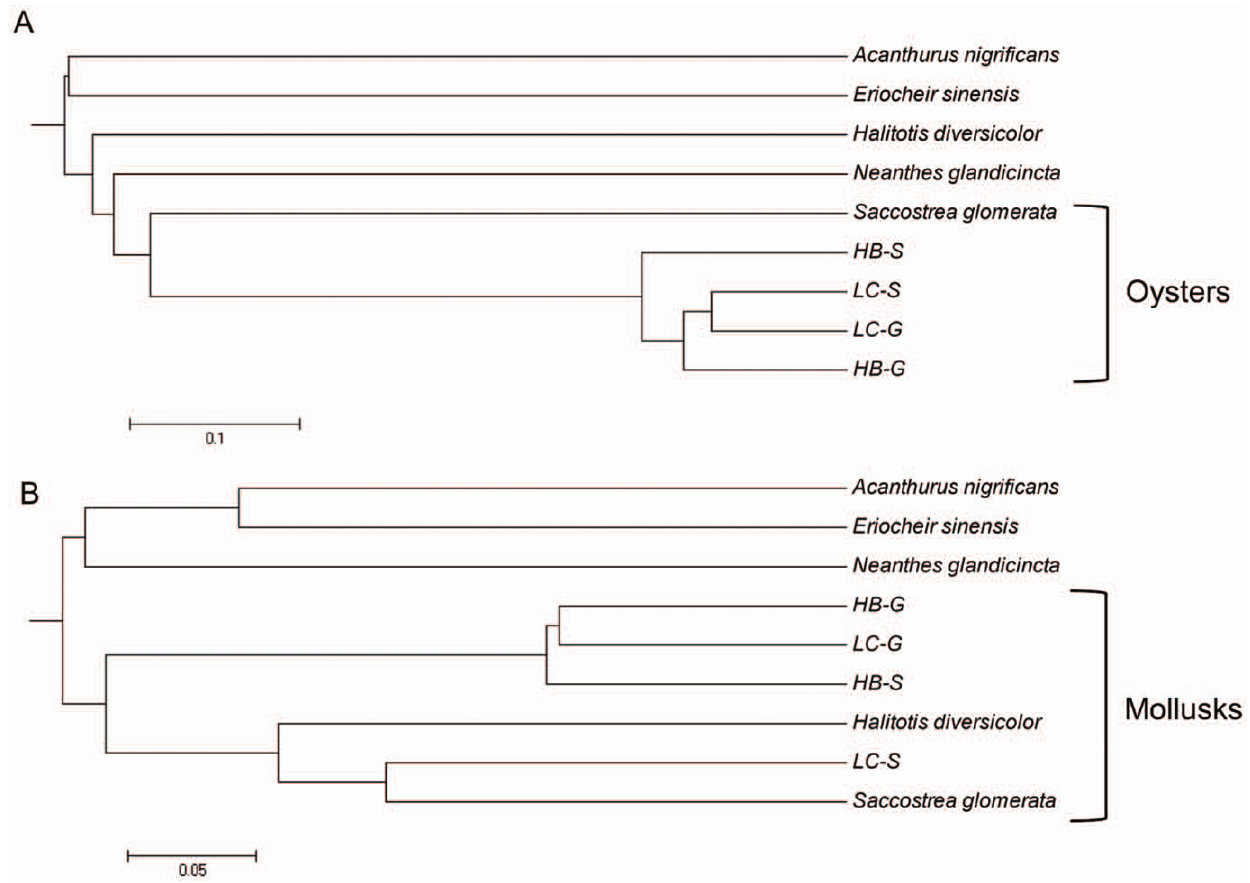
Figure 5. Cluster analysis based on unweighted (A) and weighted (B) UniFrac distances obtained for C . virginica microbiomes (HB-S, HB-G, LC-S, LC-G as above; this study) and microbiome compositions derived from 16S rRNA gene clone libraries (accession numbers in parenthesis) of an herbivorous coral reef surgeon fish, Acanthurusnigrificans (gut sequences FJ653927–FJ65392774 [ 68 ] ); the carnivorous mitten crab, Eriocheir sinensis (gut sequences DQ856498–DQ856562 [ 69 ] ); a detritivorous/phytophagus polychaete, Neanthesglandicincta (gut sequences FJ618851–FJ618896 [ 70 ] ); the macroalgae-consumng gastropod small abalone, Haliotisdiversicolor (gut sequences GU070680–GU070693 [ 41 ] ); and the filter-feeding Sydney rock oyster, Saccostreaglomerata (digestive gland sequences FM995169–FM995191 [ 33 ] ). All sequences were aligned with the NAST Aligner; a BioNJ tree was used as input for UniFrac. Weighted UniFrac was conducted with normalized sequence abundances. Note that oyster microbiomes form a distinct cluster based on the unweighted analysis (A), while in a weighted analysis (B) all mollusk microbiomes are distinct from crab, fish and polychaete microbiomes; also Lake Caillou oyster stomach microbiomes cluster with the Sydney rock oyster and small abalone microbiomes. Mollicutes dominate all of the latter [Table 1; 33, 41] and account for the observed association.